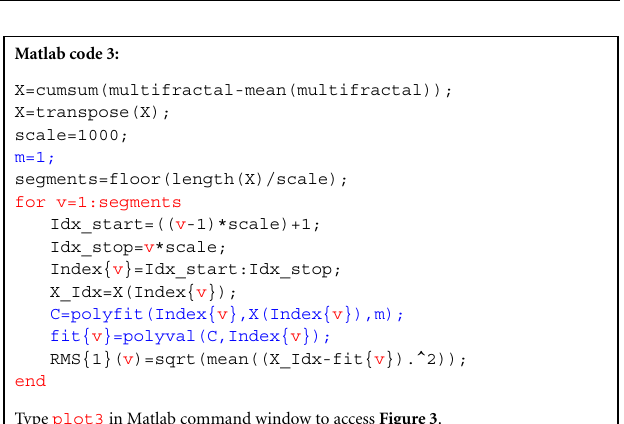
FIGURE 1 |The time series multifractal (upper panel), monofractal (middle panel), and whitenoise (lower panel) are shown as blue traces. They are examples of noise like time series used in the present tutorial. All time series contain 8000 data samples each where the sample numbers are indicated by the horizontal axis. Matlab code 1 converts the noises ( blue traces ) to random walks ( red